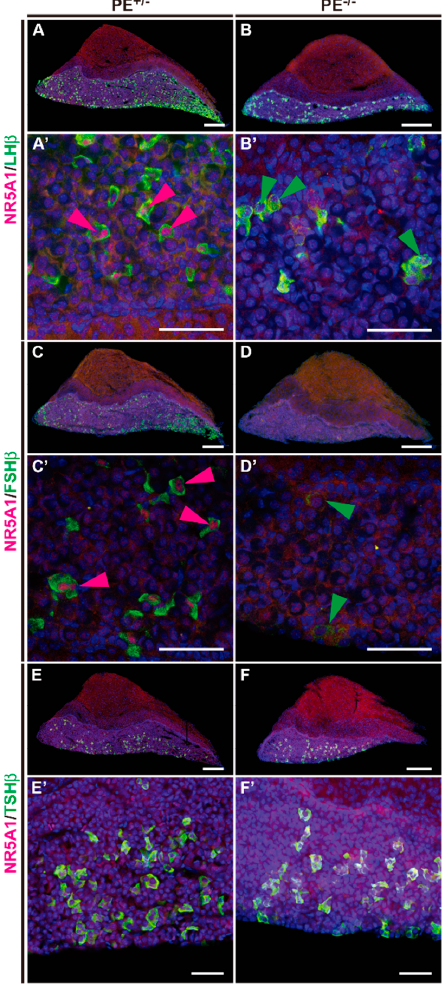
Figure 7. Levels of LH β and FSH β decreased in the PE − / − mouse pituitary; TSH β levels did not change. ( A – B ’) Immunostaining of pituitary sections using antibodies for NR5A1 (red) and LH β (green). ( C – D ’) Immunostaining of pituitary sections using antibodies for NR5A1 (red) and FSH β (green). ( E – F ’) Immunostaining of pituitary sections using antibodies for NR5A1 (red) and TSH β (green). Scale bars: 200 μ m in ( A – F ), 50 μ m in ( A ’– F ’).